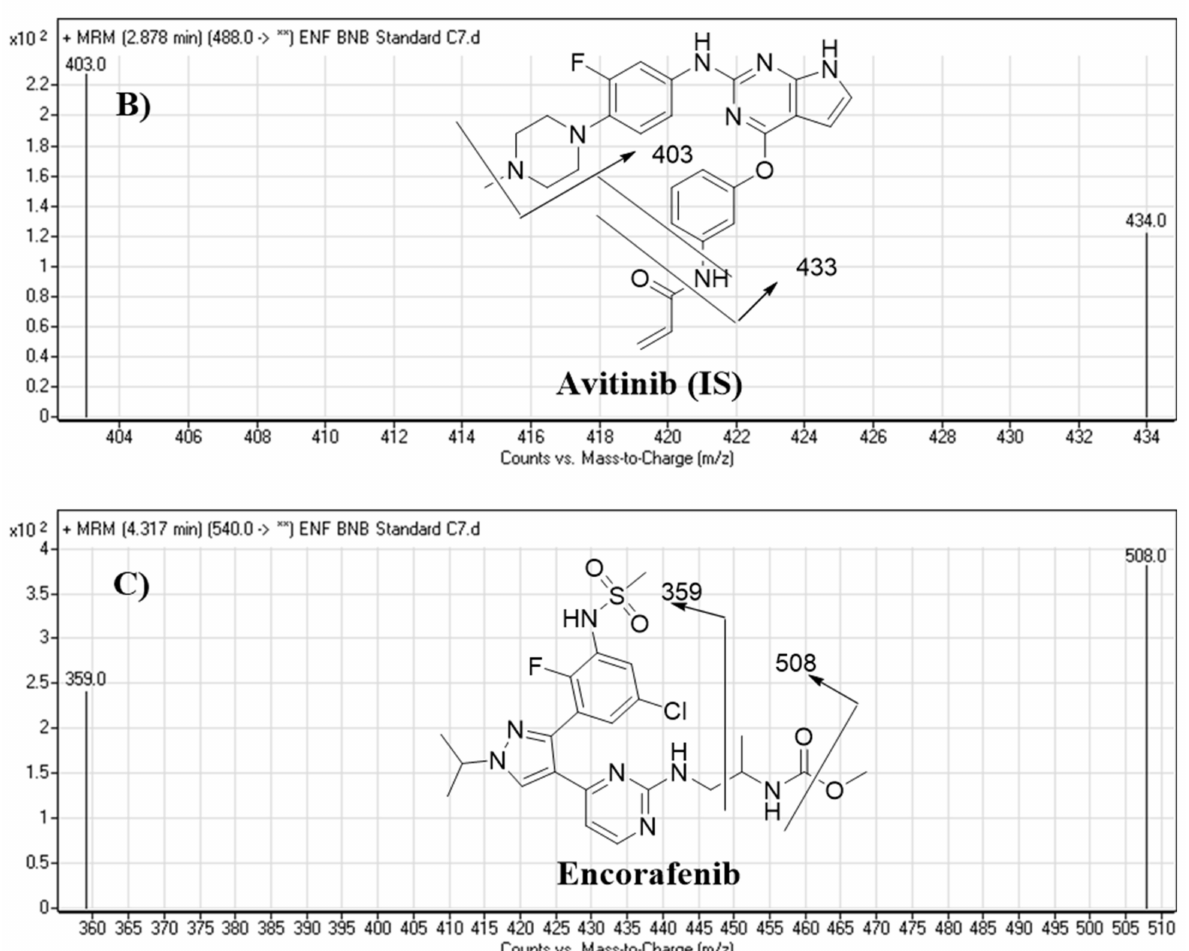
Figure 5. MRM mass transitions (parent to daughter ions) of BNB ( A ), AVB (IS) ( B ), and ENF ( C ) showing the selected daughter